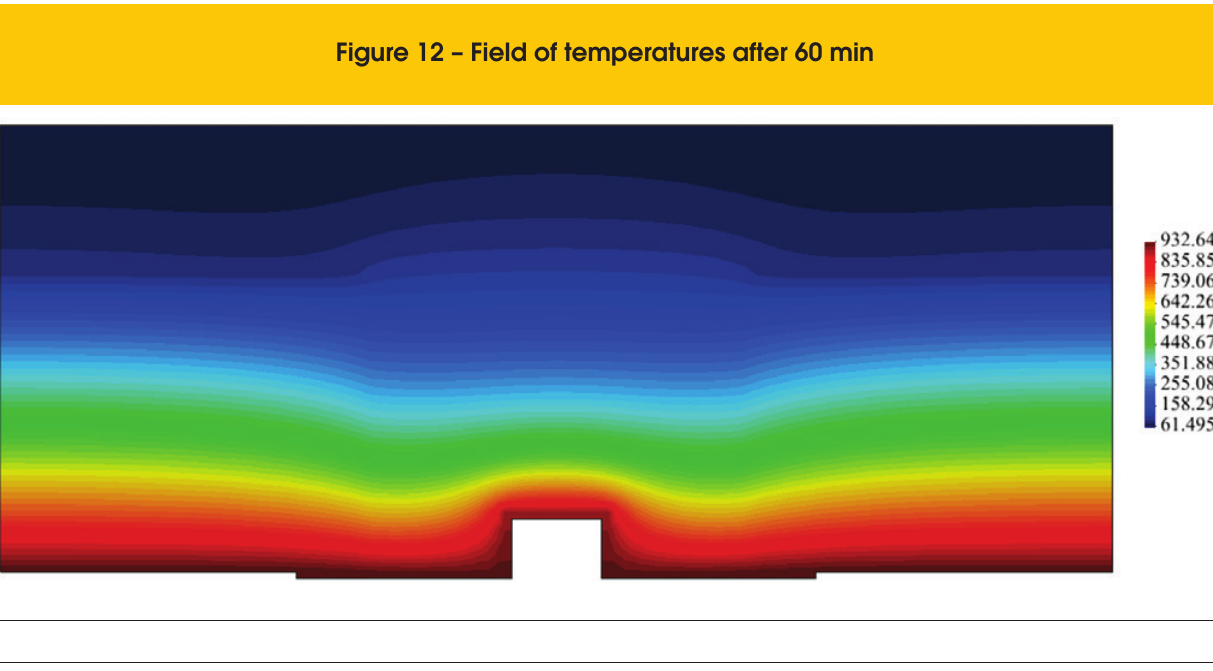
Figure 13 – 60-minute